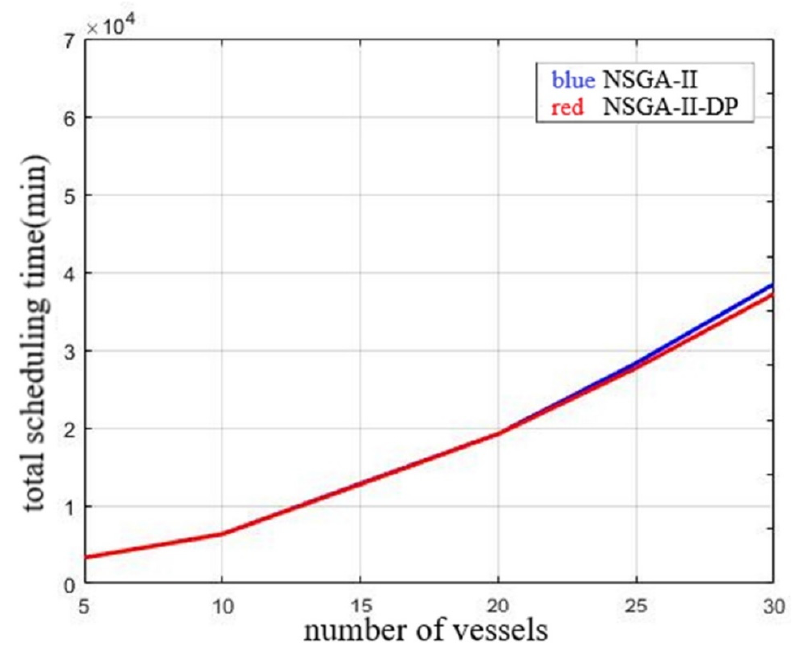
Figure 14. The average value of the optimal value of the total scheduling time over 10 calculations.